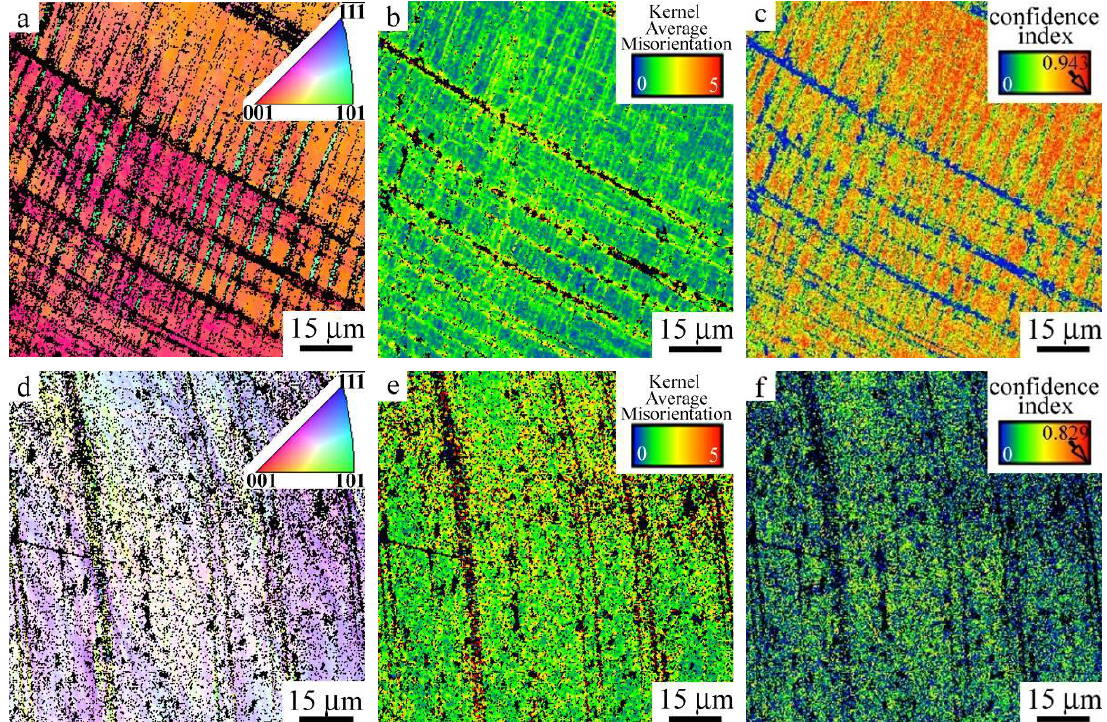
Figure 5. Typical electron back scattered diffraction (EBSD) orientation imaging maps for being annealed at 400 °С specimens of Fe-13Mn-1.3C steel pre-deformed in HPT 23 ( a – c ) and HPT 400 ( d – f ) regimes (N = 5): ( a , d )—crystal orientation maps combined with color-coded triangles for austenite; ( b , e )—Kernel average misorientation maps combined with color-coded bar; ( c , f )—CI (confidence index) maps combined with color-coded bar. All maps and color-coded triangles in ( b ), ( e ) correspond to austenitic phase. EBSD maps correspond to the rotational plane of the plunger in HPT.